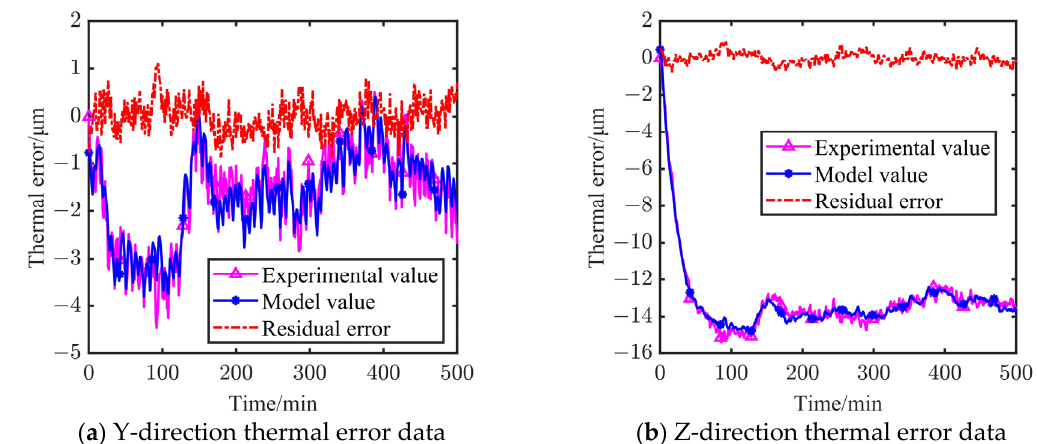
Figure 5. The fitting results and residual error of the first machine tool. According to the analysis in Figure 5, after thermal error compensation, the accuracy in the Y direction and Z direction increased by 75% and 93%, respectively, which verifies the effectiveness of the modeling theory.